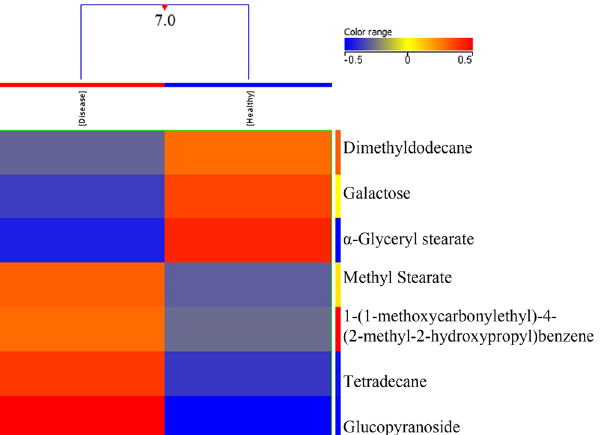
Figure 1. Dendogram showing comparison of healthy controls and Breast Cancer patients using normalized intensities of seven significant metabolites (p < 0.05). The dendogram was constructed by applying a hierarchical clustering algorithm (Canberra, absolute distance metric, complete